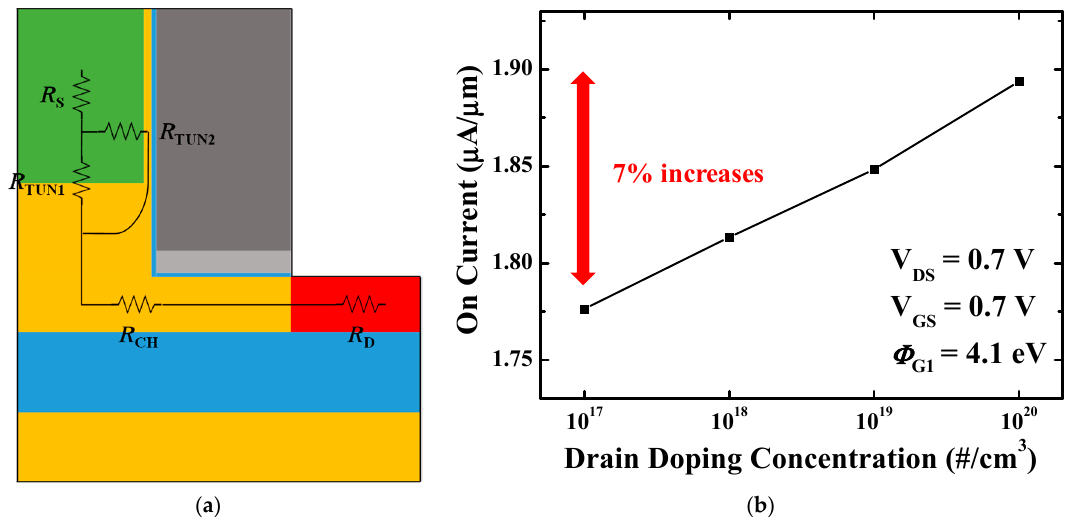
Figure 8. ( a ) Resistance network when the device is in the on-state. R TUN1 and R TUN2 are the tunneling resistances; ( b ) on-current with the drain doping concentration. After changed the source material to SiGe, 7% on-current increases with the drain doping concentration.